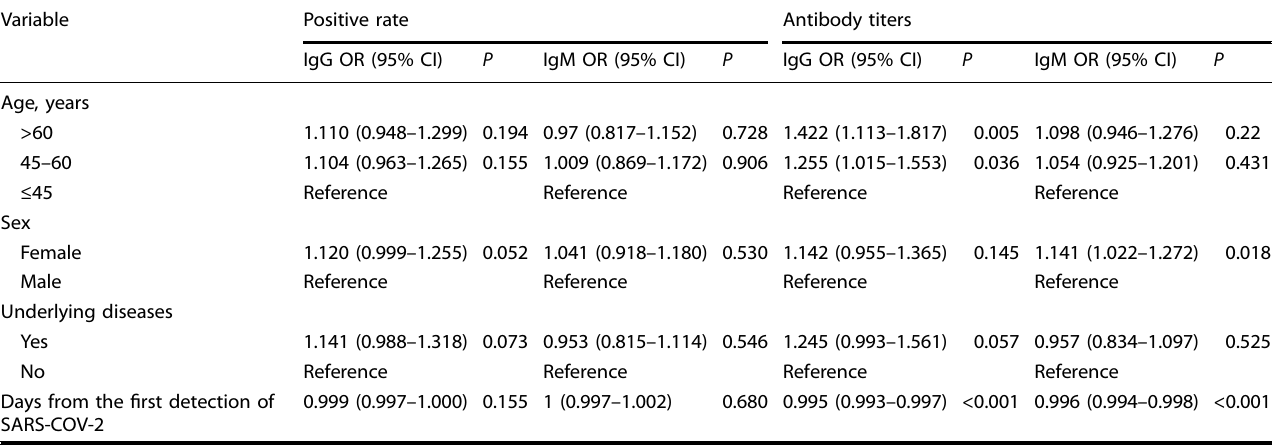
Table 2. The related factors associated with IgG and IgM antibody levels and positive rates of the asymptomatic individuals with SARS-CoV-2 infection by generalized estimating equation